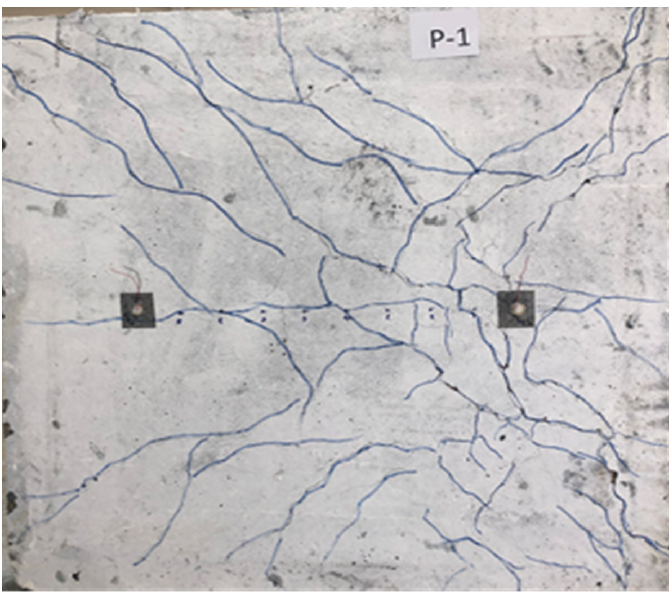
Figure 6. Crack and failure pattern of a slab with an opening. ( a ) Control sample without fiber; ( b ) Slab with straight steel fiber; ( c ) Slab with hooked steel fiber; ( d ) Slab with corrugated steel fiber; ( e ) fibers with less ductile behavior. Table 7 and Figure 8 show the cracking loads for different Slab with Polyolefin fiber; ( f ) Fracture failure of slab with fiber. type of fiber for slabs both with and without openings.